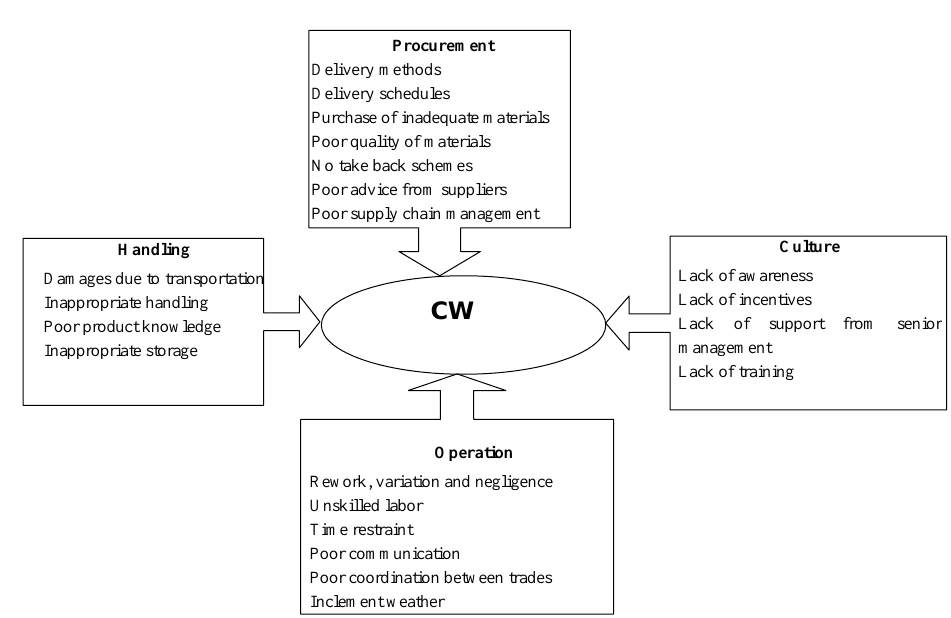
Figure 1. Source of Construction waste (CW).